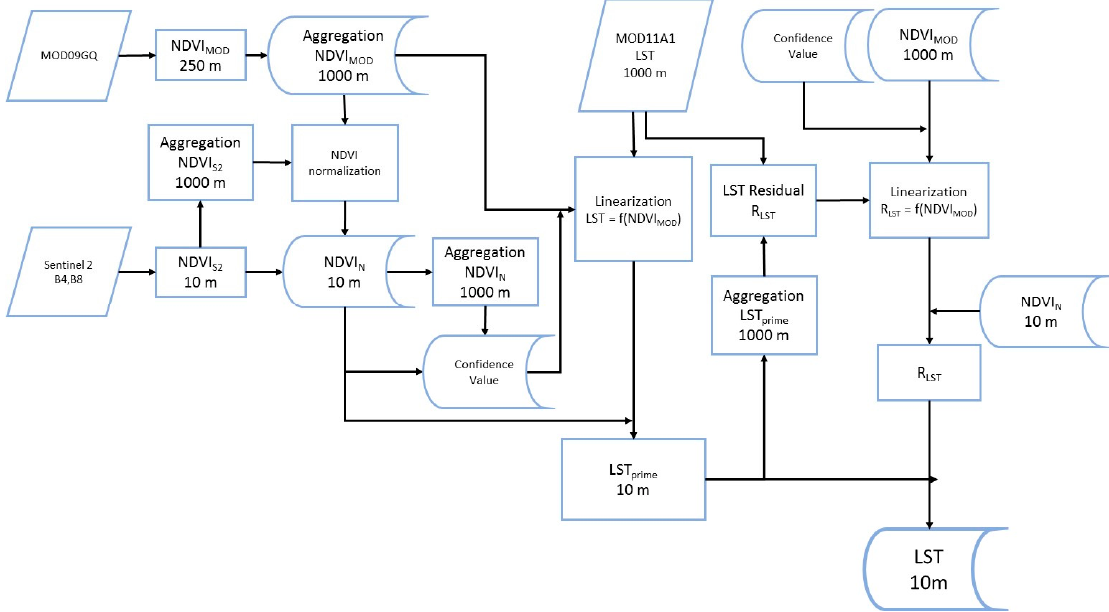
Figure 4. Flowchart of the downscaling methodology, including the different processing steps, inputs and outputs. Variable descriptions are included in the text.